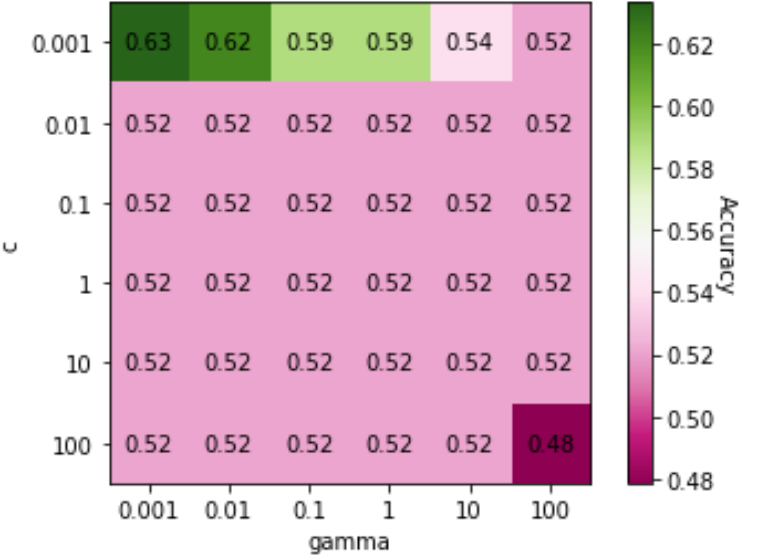
Figure 5. Heatmap of values of SVM parameters C and γ on Dataset 05.